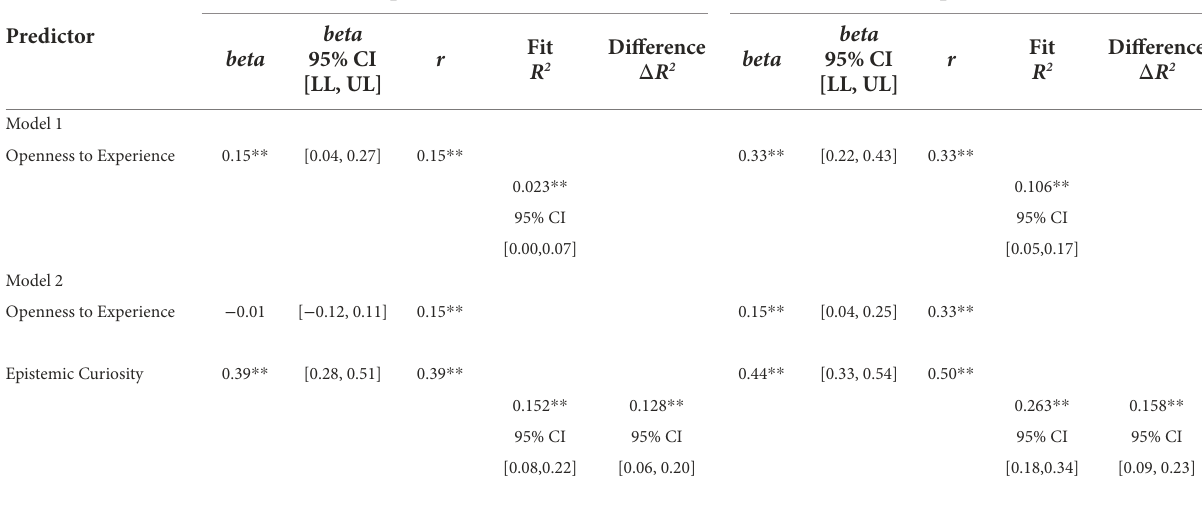
TABLE 5 Regression results for Hypothesis 2.